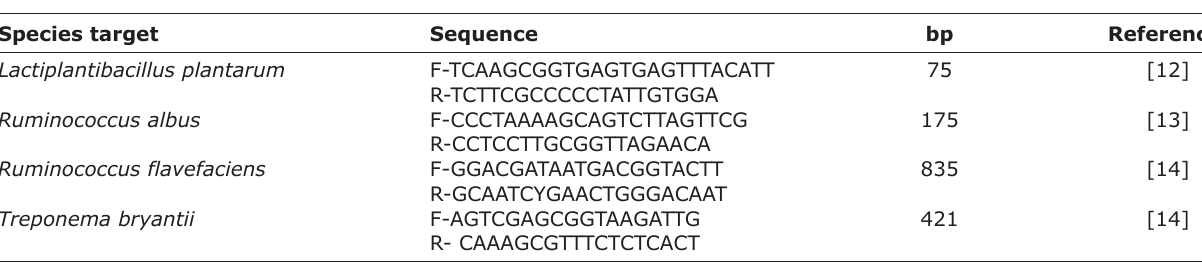
Table-1: Primers used for quantitative real-time